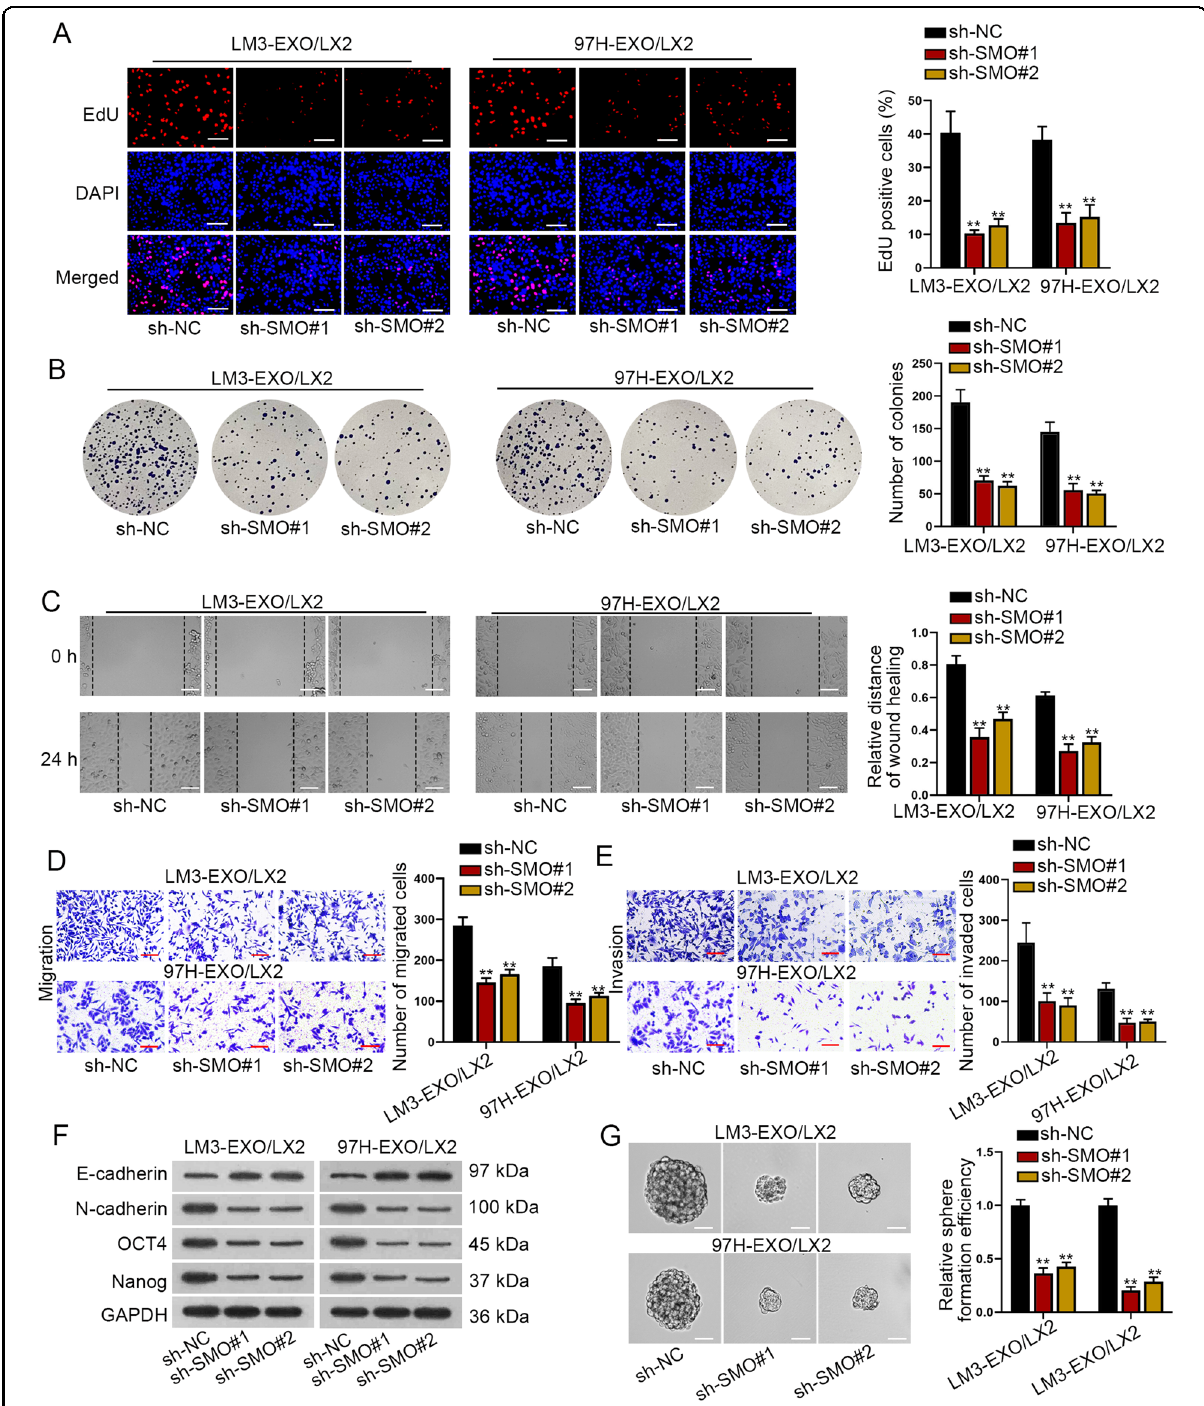
Fig. 3 SMO facilitated the proliferation, migration, invasion, EMT, and stemness of activated HSCs. A – B EdU (bar value = 100 μ m) and colony formation assays depicted the proliferation of exosomes-activated HSCs with or without knockdown of SMO. C – E . Wound-healing (bar value = 80 μ m) and transwell assays (bar value = 50 μ m) unveiled the in fl uence of silenced SMO on the migration and invasion capacity of exosomes- activated HSCs. F Western blot detected the levels of E-cadherin, N-cadherin, OCT4, and Nanog in exosomes-activated HSCs cells with or without SMO de fi ciency. G Sphere formation assay (bar value = 50 μ m) uncovered the in fl uence of silenced SMO on the stemness of activated HSCs. ** P <